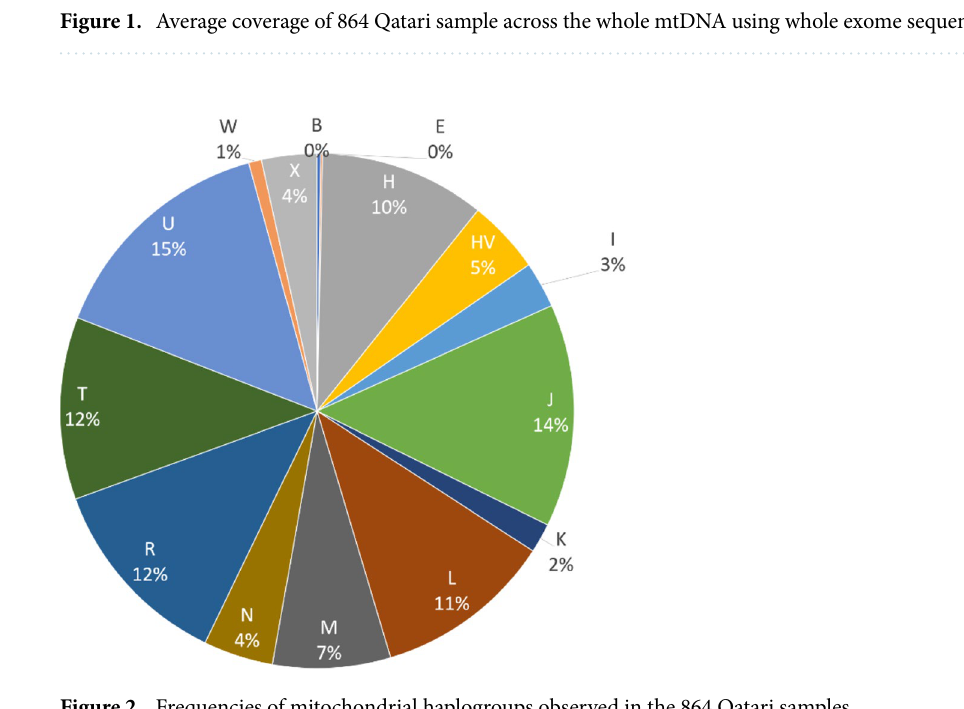
Figure 2. Frequencies of mitochondrial haplogroups observed in the 864 Qatari samples.